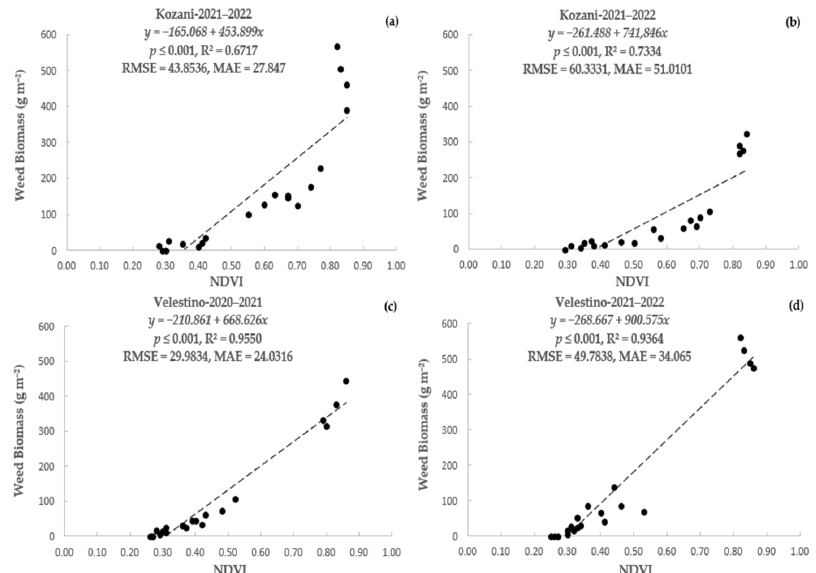
Figure 3. Linear regression between weed biomass ( y ; g m − 2 ) and weed NDVI ( x ) in ( a ) Kozani-2020– 2021 (intercept SE: 61.7081; slope SE: 101.656), ( b ) Kozani-2021–2022 (intercept SE: 42.7949; slope SE: 71.8811), ( c ) Velestino-2020–2021 (intercept SE: 16.8116; slope SE: 34.1459), and ( d ) Velestino-2021–2022 (intercept SE: 26.5378; slope SE: 53.7127). Model DF: 1; Residual DF: 18; Total DF: 19; DF: Degrees of Freedom; SE: Standard Error; RMSE: Root Mean Square Error; MAE: Mean Absolute Error; R 2 : Coefficient of Determination (adjusted for